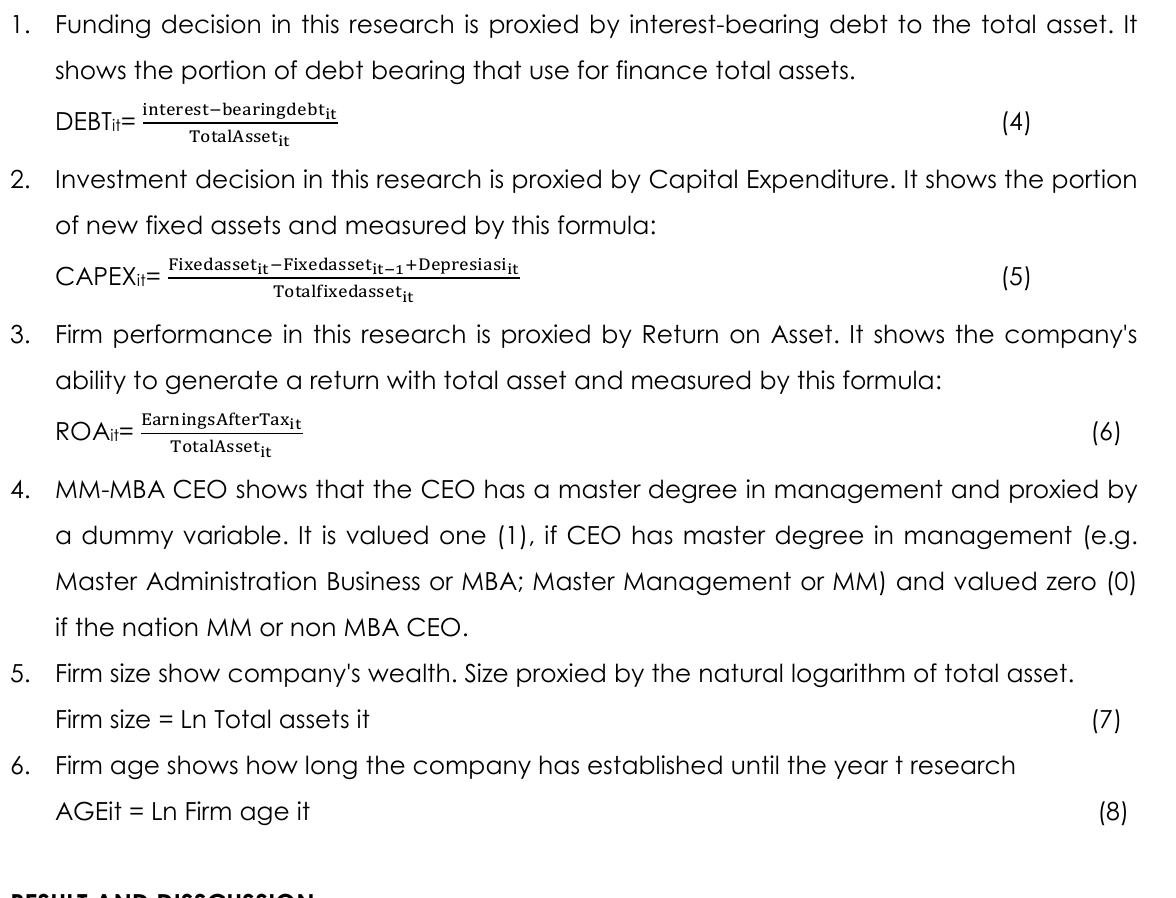
on Assets, firm size, and firm age are 0.196 (0.163), 0.222 (0.325), 0.071 (0.088), 0.247 (0.432), 28.366 (1.840), and 3.452 (0.559) respectively. Variable EDU in table 1 shows there are